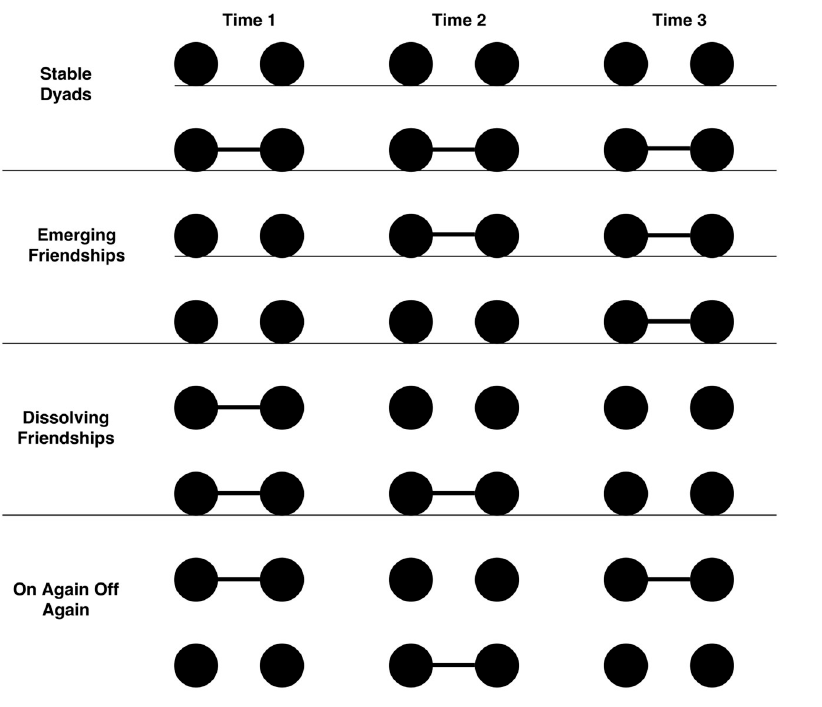
Fig 1. The story arc of